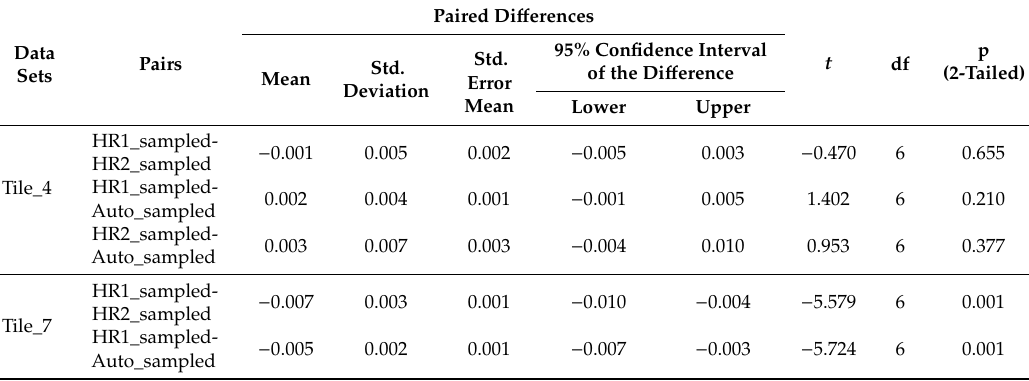
Table 6. Results of paired t -test for comparing the DRP concentrations obtained by the hybrid resin- sampling method and the auto-sampling method. The passive-sampling data was calculated based on the field calibration data. DPR concentrations of each auto-sampled tile water were compared with the calculated DPR concentration in corresponding passive-sampling periods. The data are shown in Figure